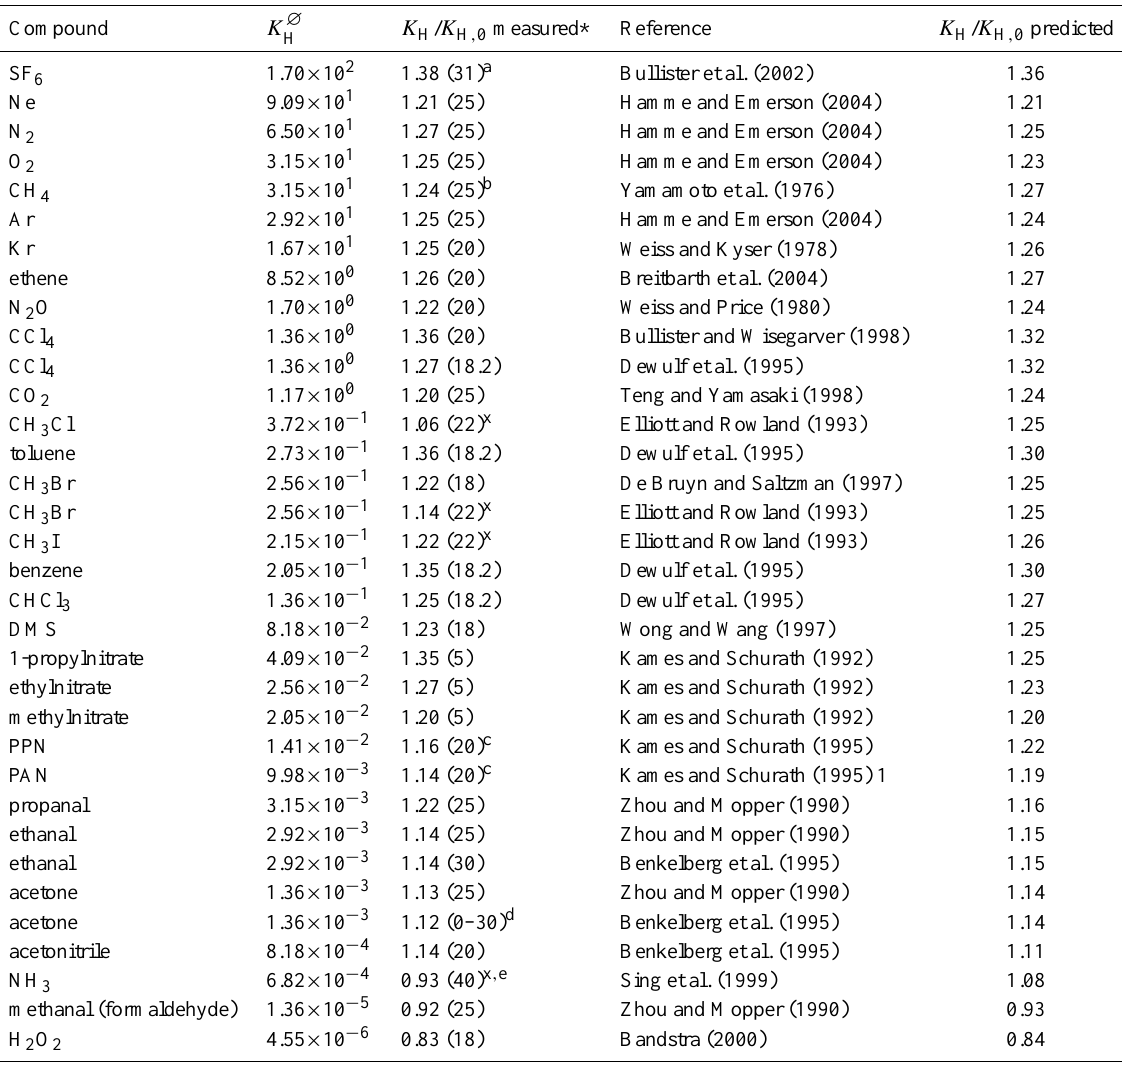
Table 1. K H / K H , 0 (salting out factor) for gases measured in natural or synthetic seawater at salinity between 35 and 36 (except where otherwise stated), compared to values predicted by Eqs. (19) to (21). Notes: * – measurement temperature given in parentheses; x – denotes data not used to derive Eq. 21; a – S = 39; b – S = 34, 0.6 ◦ C difference between fresh and salt-water measurements; c – synthetic seawater; d – mean of 0, 15 and 30 ◦ C measurements; e – measurement in S ≈ 400 at 40 ◦